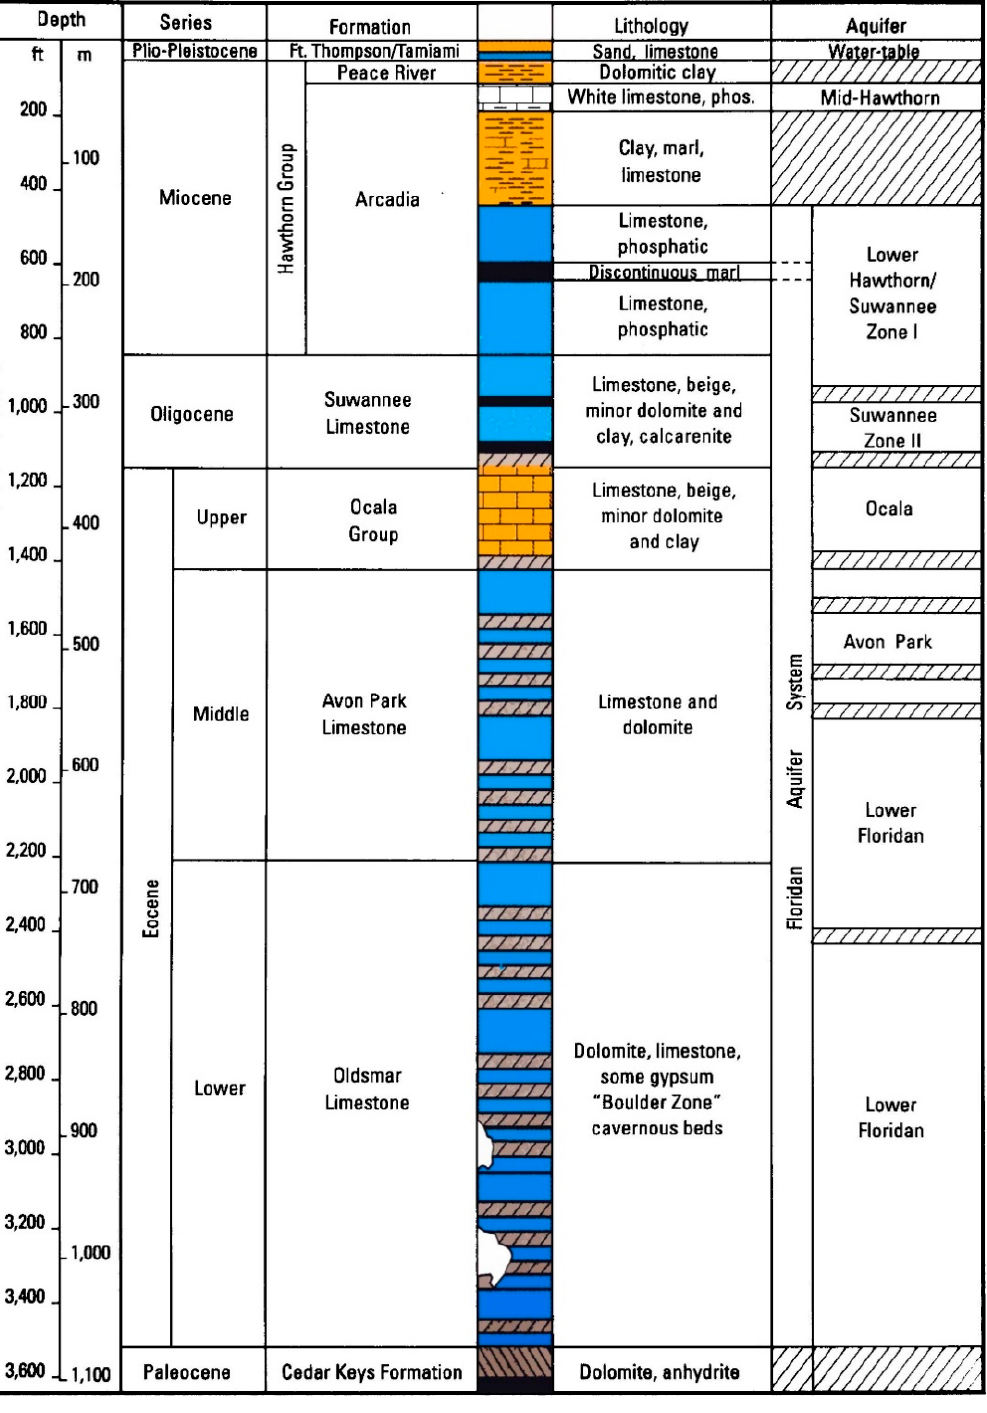
Figure 4. Hydrogeologic section beneath the City of Cape Coral (from [12,21]). The salinity of water in the Floridan Aquifer System increases with depth [12,21]. The dissolved chloride concentration profile that was used to create the solute transport model used for planning in the City is shown in Figure 8. Note that water occurring below the Lower Suwannee aquifer would likely require a seawater membrane to be used to produce potable water. The dissolved chloride concentration in the Ocala Aquifer increases to above 10,000 mg/L. True seawater with a dissolved chloride concentration of about 19,500 mg/L does not occur until a depth near 550 m below surface within the Avon Park